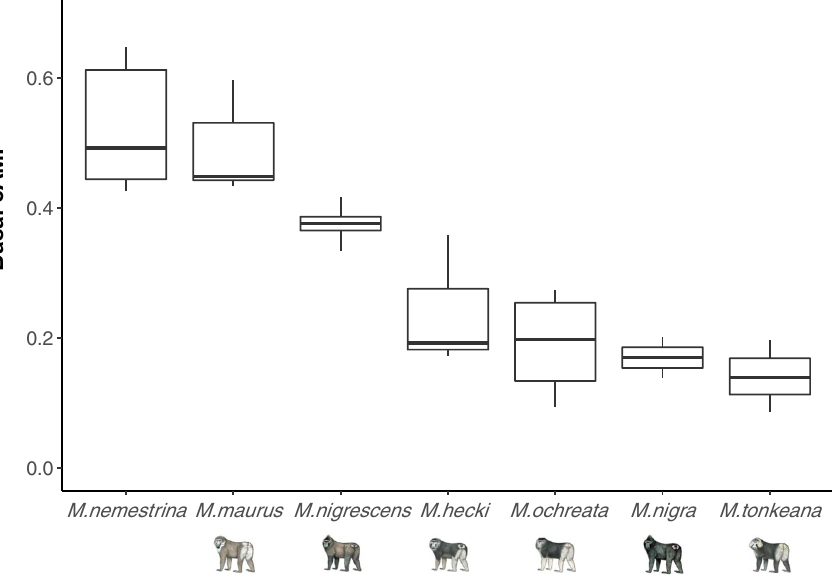
Figure 4. Basal cAMP production of species-specific MC1R variants in Sulawesi macaques. Basal cAMP production was normalized to the maximum cAMP production under activation by 20 µM forskolin. M. nigra, M. ochreata, M. hecki, and M. tonkeana MC1R showed significantly lower basal cAMP production than levels for M. nemestrina and M. maurus (Pairwise t -test with BH correction, P < 0.05) . M. nigrescens displayed intermediate basal cAMP production, significantly lower than that of M. nemestrina (Pairwise t -test with BH correction, P < 0.05).